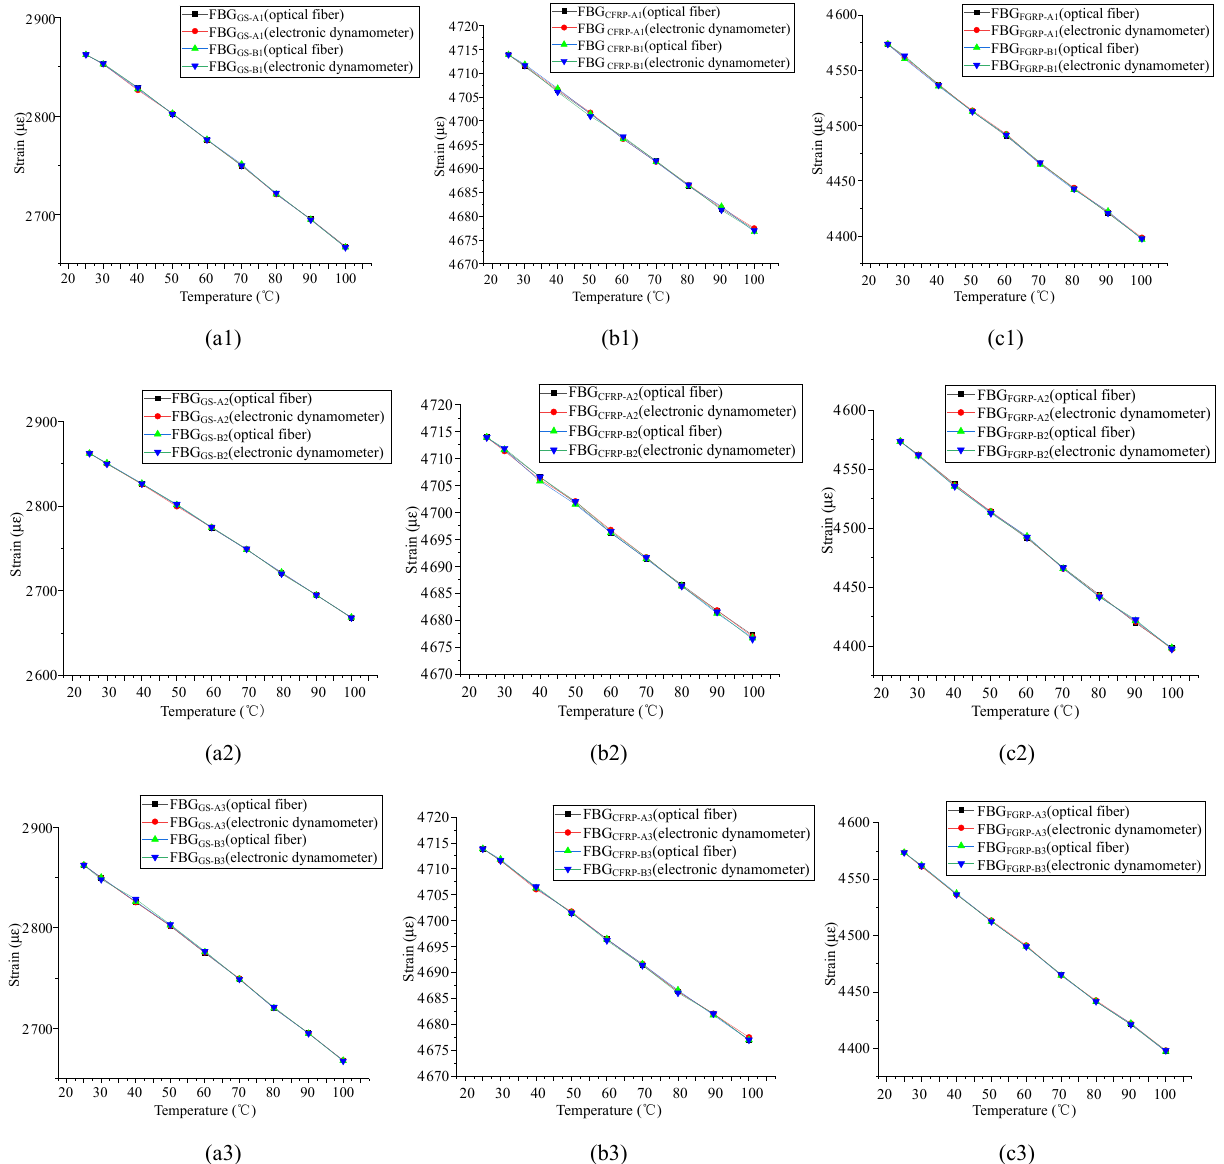
Fig. 10 Comparison between the strain value obtained after temperature compensation of the corresponding variable grating and the strain value measured by the electronic dynamometer : (a1) FBG GS-A1 and FBG GS-B1 , (a2) FBG GS-A2 and FBG GS-B2 , (a3) FBG GS-A3 and FBG GS-B3 , (b1) FBG CFRP-A1 and FBG CFRP-B1 , (b2) FBG CFRP-A2 and FBG CFRP-B2 , (b3) FBG CFRP-A3 and FBG CFRP-B3 , (c1) FBG FGRP-A1 and FBG FGRP-B1 , (c2) FBG FGRP-A2 and FBG FGRP-B2 , and (c3) FBG FGRP-A3 and FBG FGRP-B3 . Note: the optical fiber in the figure is the strain value measured by the embedded fiber grating, and the electronic dynamometer is the strain value measured by the electronic